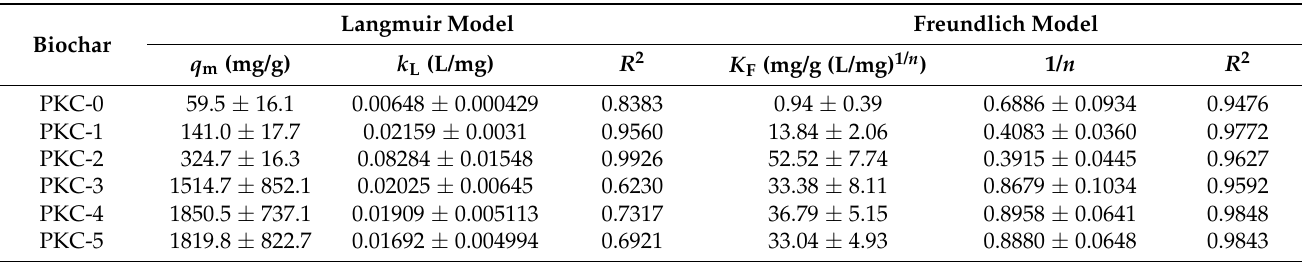
Table 3. Adsorption isotherm parameters of Langmuir model and Freundlich model for OTC adsorption on biochars.